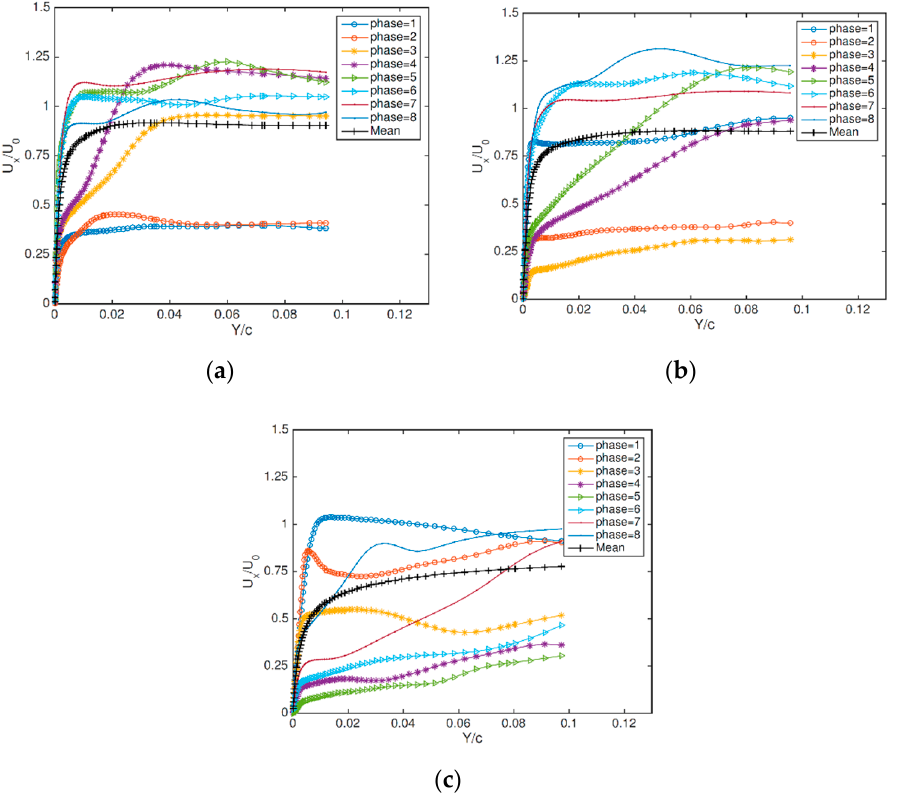
Figure 21. Instantaneous velocity profiles of 𝑈 (cid:3051) parallel to airfoil surface. ( a ) 𝑥/𝑐 = 0.3 ; ( b ) 𝑥/𝑐 = 0.5 ; ( c ) 𝑥/𝑐 = 0.8 .